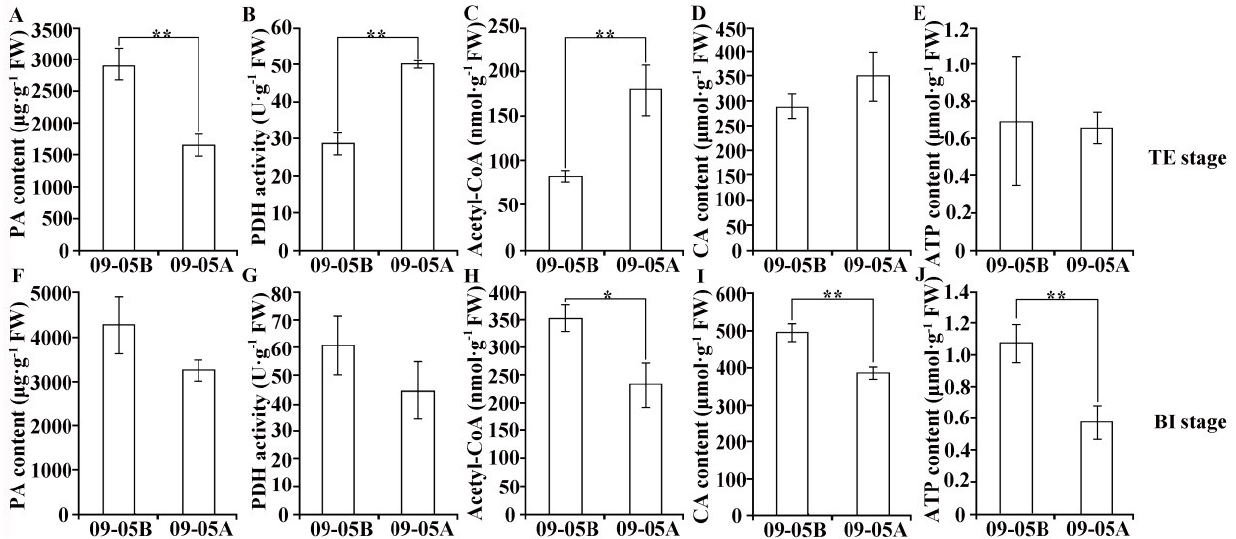
Figure 6. Determination of metabolic products and enzyme activity in 09-05A and 09-05B at the TE and BI stages of B. juncea . ( A , F ) Determination of PA content. ( B , G ) Determination of PDH activity. ( C , H ) Determination of acetyl-CoA content. ( D , I ) Determination of CA content. ( E , J ) Determination of ATP content. All data are shown as the mean ± SD from three independent biological replicates.